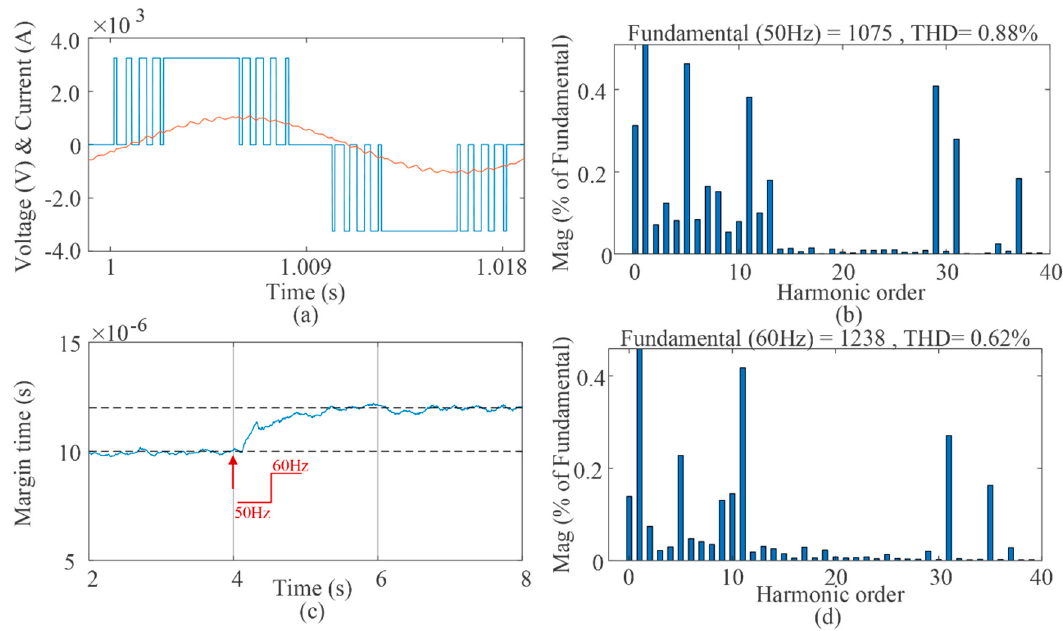
Figure 22. Detailed bridge arm voltage and current ( a ), the THD analysis of line current ( b ) at non-quasi-unit power factor angle. Dynamic process ( c ) and steady state current THD ( d ) in variable frequency situation.